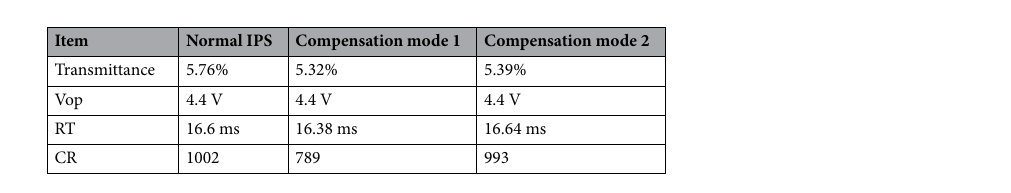
Table 1. The electric-optical characteristics.